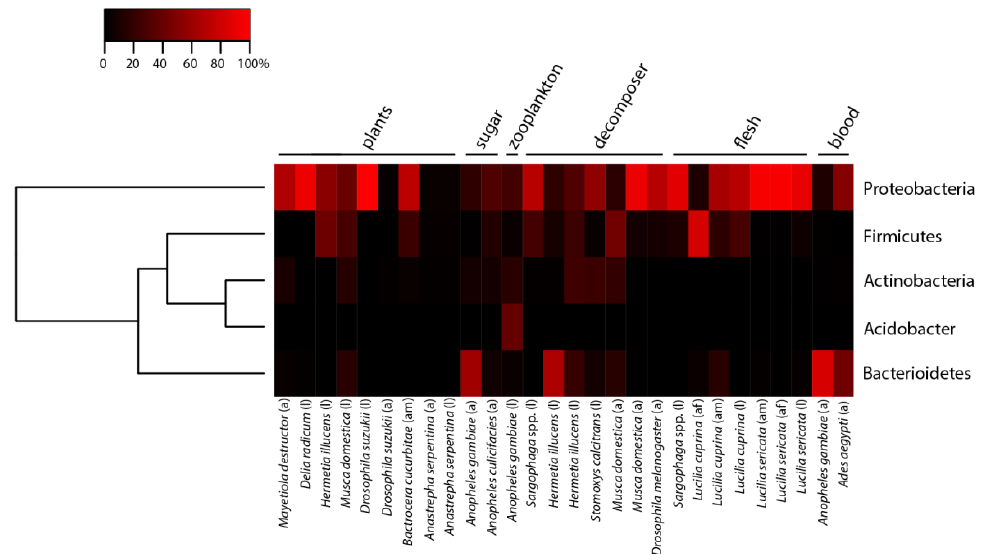
Figure 1. Gut bacterial community composition in Diptera that is based on the studies in Table 1. Heatmap of gut bacterial composition in dipteran species feeding on various diets (plants, sugar, zooplankton, decomposer, flesh, or blood). Relative abundance (percentage of total) of bacteria is indicated at a phylum level. The life stages of the hosts (a: adult, l: larvae) and their sex (m: male, f: female) are indicated next to the species name.